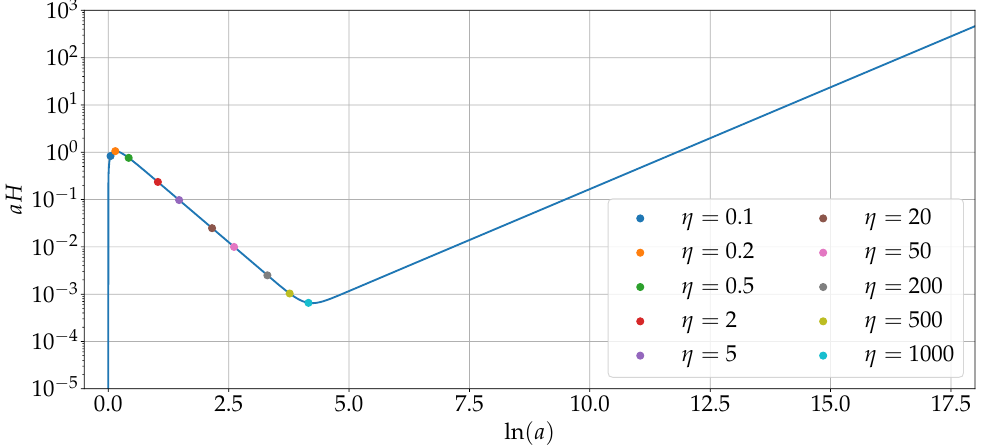
Figure 9. Different choices of time between the bounce and the onset of inflation, and value of aH at those times, for the background solution studied in Section 5.